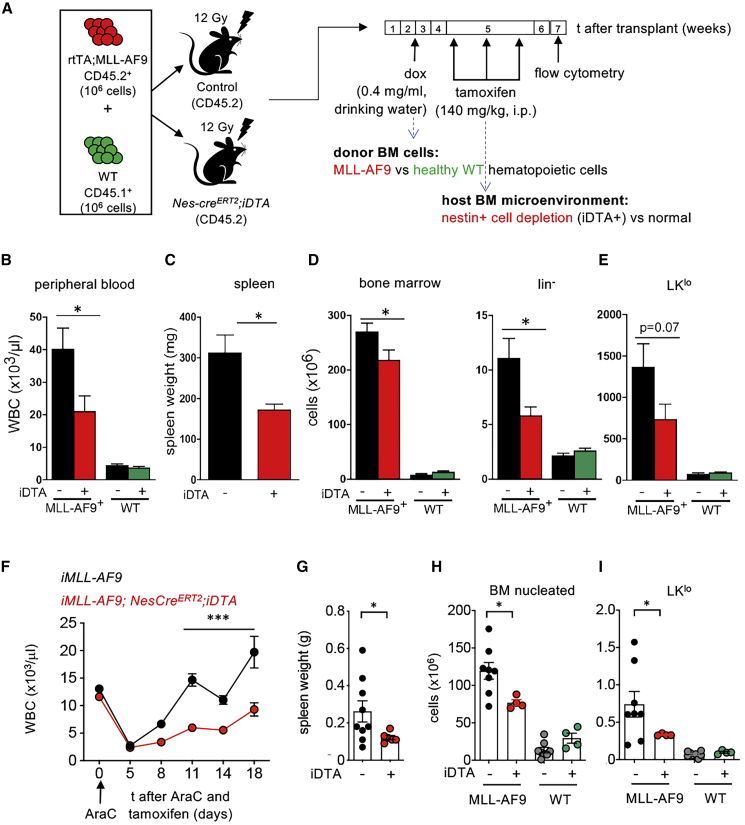
Nestin+ Cells Promote Leukemia Chemoresistance In Vivo(A) Scheme showing the experimental setting to simultaneously study the impact of nestin+ cell depletion on healthy and leukemic hematopoietic cells. Lethally irradiated CD45.2 control mice or Nes-creERT2;iDTA mice were transplanted with 106 iAML (rtTA;MLL-AF9) CD45.2+ BM nucleated cells and 106 CD45.1+ WT BM nucleated cells. Doxycycline administration started 2 weeks after transplant; tamoxifen was administered 4 weeks post-transplant and mice were sacrificed and analyzed 4 weeks later.(B–D) Number of WT and MLL-AF9+ WBC (B), spleen weight (C), BM nucleated, and lineage-negative cells (D).(E) BM lin−ckitlosca1− (LKlo) cells. Data in (D and E) represent the cellularity of 4 limbs, sternum, and spine (n = 18 mice/group, pooled from 3 independent experiments).(F–I) Nestin+ cells support chemoresistance in AML mice. (F) WBCs, (G) spleen weight, (H) BM nucleated cells, and (I) LKlo cells in control (iDTA−) or Nes-creERT2;iDTA (iDTA+) mice transplanted with a mixture of WT and iMLL-AF9 BM cells, receiving tamoxifen and AraC treatment simultaneously, as in Figure S1A (n = 4–8). Dots represent data from individual mice. Data are mean ± SEM. ∗p < 0.05; ∗∗∗p < 0.001; unpaired two-tailed t test.